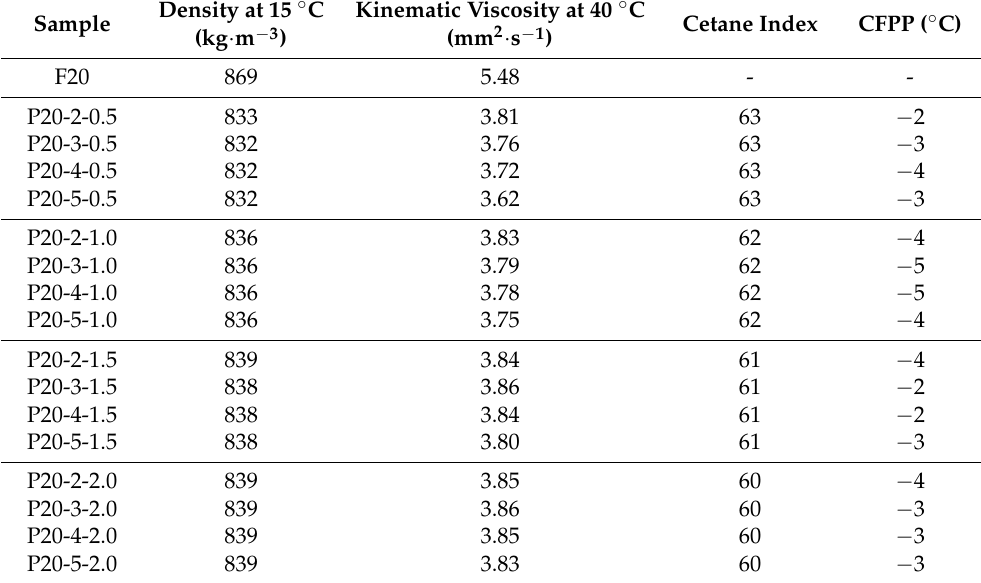
Table 8. The selected properties of the F20 feedstock and the P20 liquid